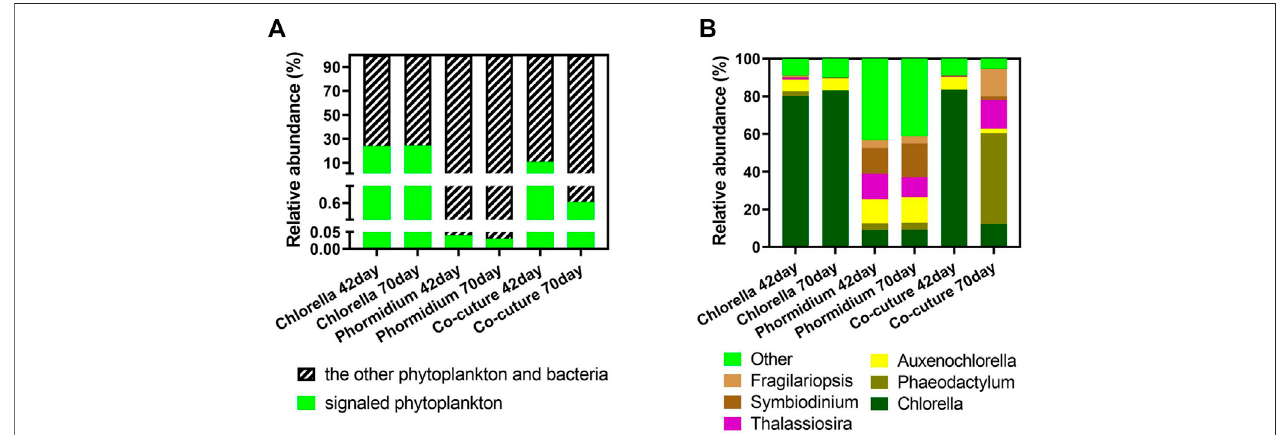
FIGURE 9 | Network between bacteria and phytoplankton. (A) Signaled bacteria and eukaryotic phytoplankton, (B) non-signaled bacteria and eukaryotic phytoplankton, (C) signaled bacteria and Chlorella , and (D) non- signaled bacteria and Chlorella . Orange nodes represent bacteria, and green nodes represent phytoplankton. Red lines represent positive correlation, and blue lines represent negative correlation.